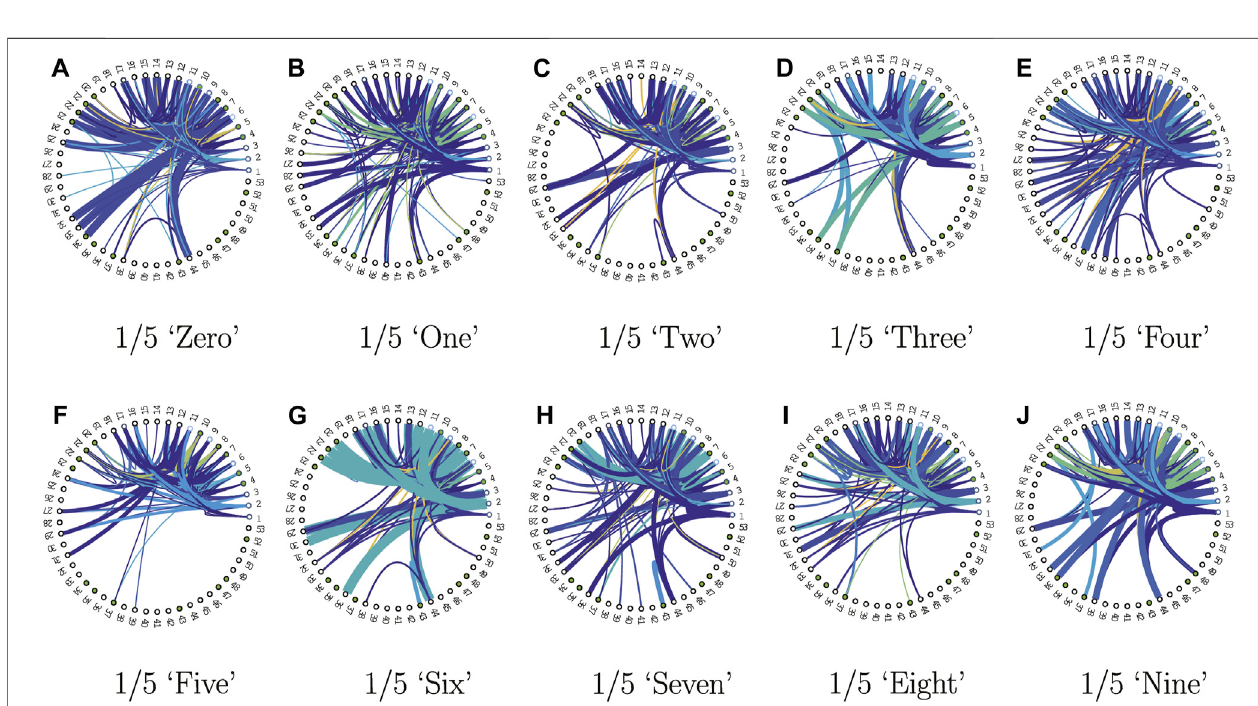
FIGURE 5 | State connectivity graphs for the fi rst networks of the ten SPARK word models, with training accuracy of 97.96% and testing accuracy of 95.31%: (A) corresponds to the fi rst network of the 5-network KAARMA chain (denoted by 1/5) word model for the digit “ zero ” , etc. Accept states are marked by fi lled green dots. Only the upper-triangular destination-state connections are considered in the connectivity graphs, with self-transitions ignored.